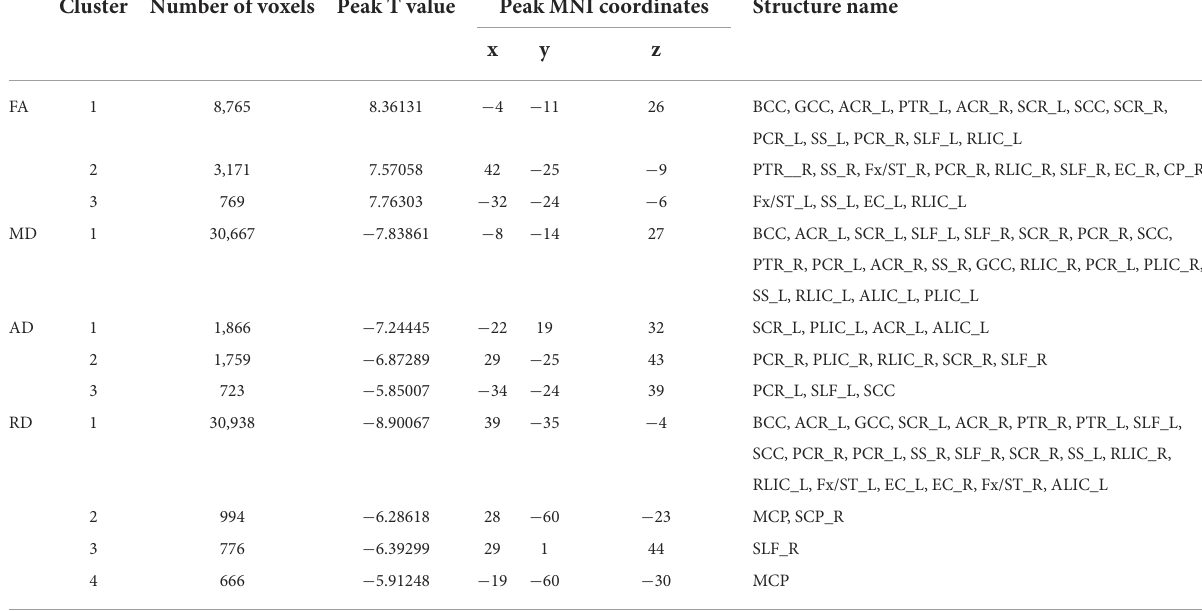
TABLE 5 Regions with significant differences between the DD-CKD and NC groups (only clusters larger than 500 voxels are listed). Cluster Number of voxels Peak T value Peak MNI coordinates Structure